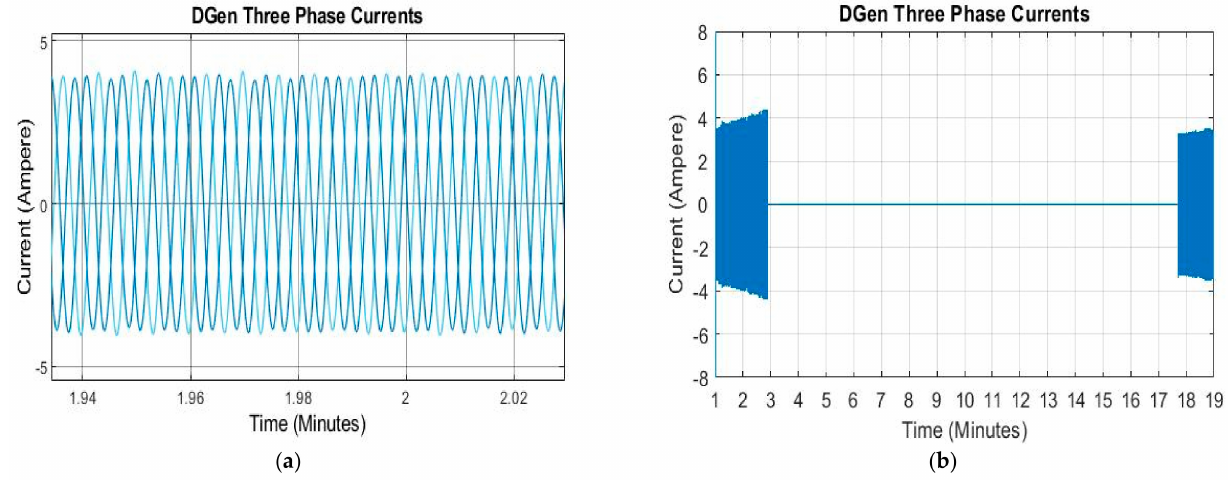
Figure 24. ( a ) Zoom in view of three phase currents. ( b ) Three phase currents of DGen.